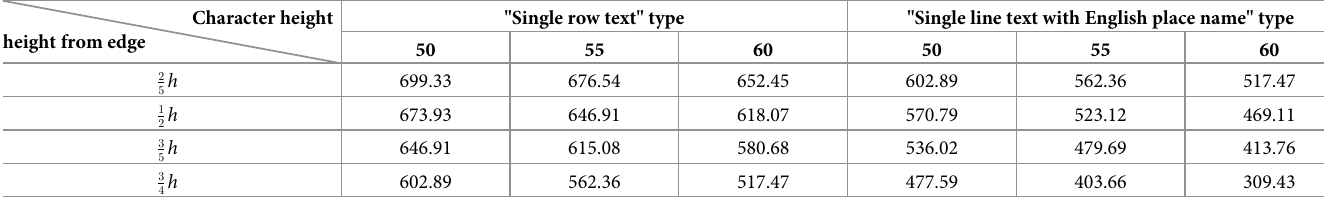
Table 2. Maximum layout width of exit warning signs under different constraints. Character height height from